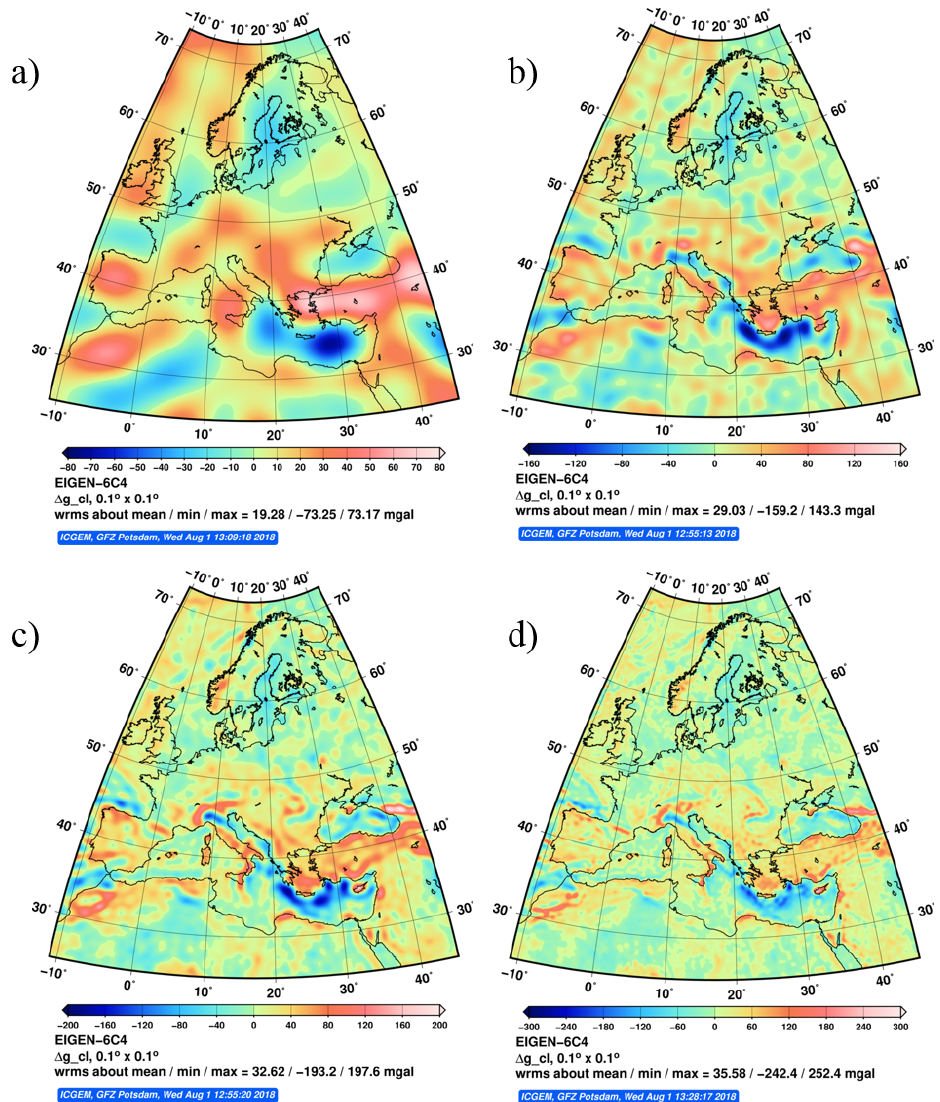
Figure 8. Geographical distribution of gravity anomalies in mGal with different spectral ( l max ) and spatial resolution (half wavelength λ min /2) of EIGEN-6C4. Spherical harmonic degree expansions for the four examples are as follows: (a) 50, (b) 150, (c) 250, and (d) 500 which correspond to 400, ∼ 133, 80, and 40km half wavelength spatial resolutions. See the refined features and better spatial localization as the model expansion increases. For instance, topographical features such as mountains are well resolved in (d) , whereas they are not precisely located in (a) . The transmission borders of higher and lower anomalies in Alps and Mediterranean Sea are better resolved in (d) , whereas it is not possible to distinguish and locate them precisely in (a) . Note the different colour scales which have not been changed and kept as retrieved from